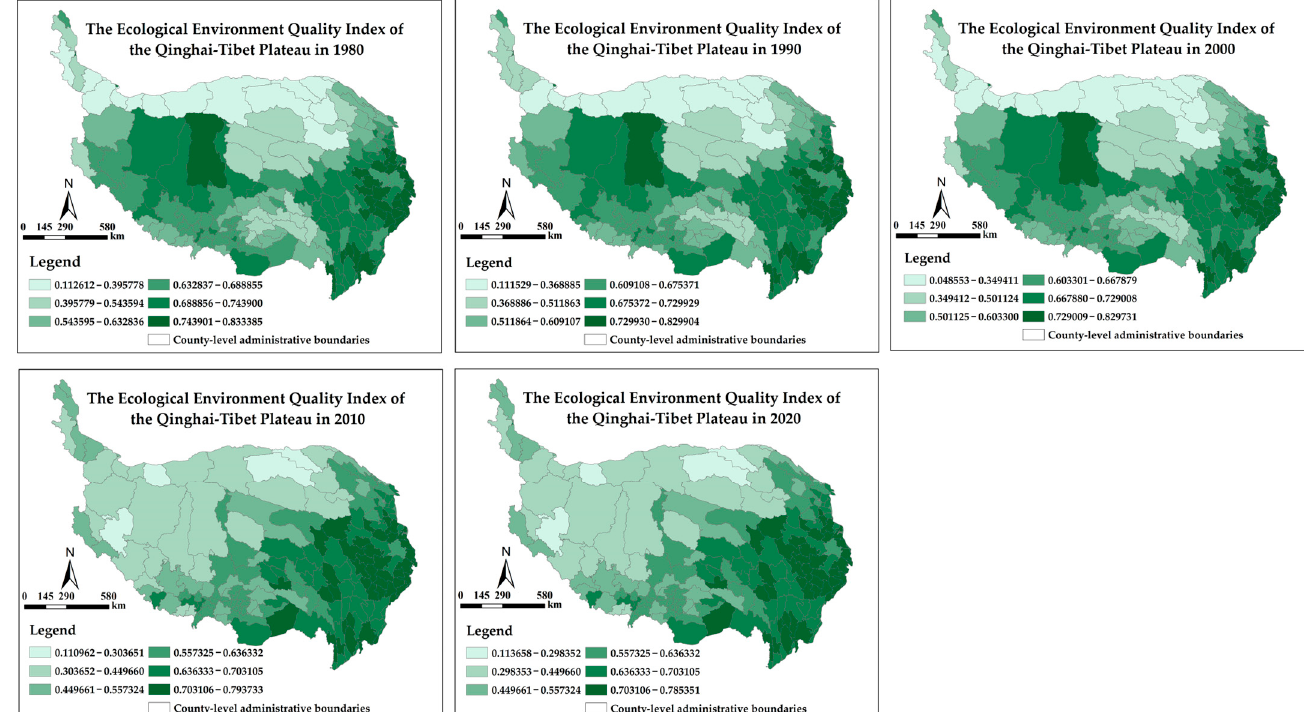
Figure 5. Spatial distribution of EEQI in the QTP from 1980 to 2020.